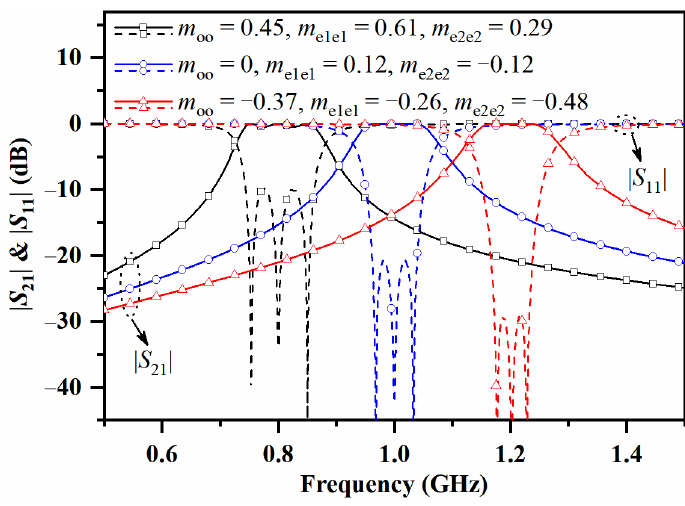
Figure 5. Theoretical curves for varying m e1e1 , m oo and m e2e2 considering a fixed Q e = 28.